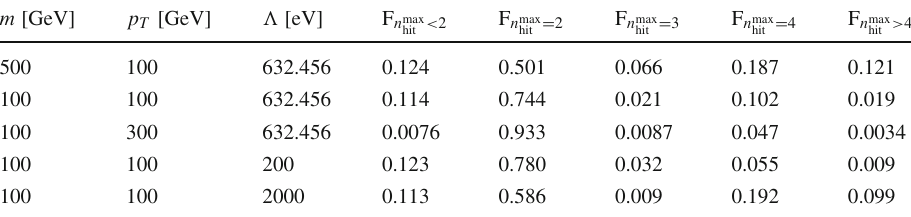
Table 1 The fraction of quirk pair events that leave at most n hits on each tracking layer of the CMS detector is denoted by F n max = n . The different processes hit are characterized by fixing quirk mass m , confinement scale